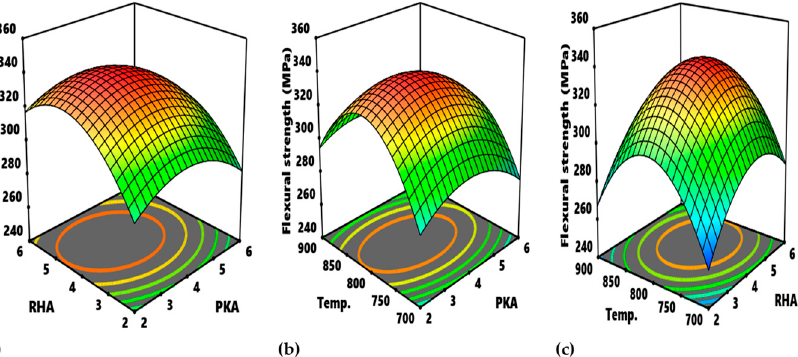
Figure 13. Surface plots representing the relationship of the variables that affect flexural strength as revealed by interactions ( a ) PKA vs. RHA, ( b ) PKA vs. stirring temperature, and ( c ) RHA vs. stirring